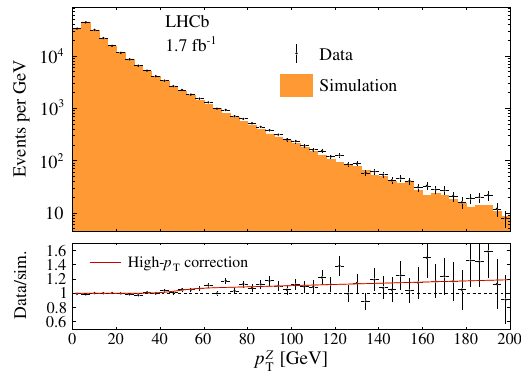
compared to the POWHEGPythia model prior to the parametric Figure 8 . Distribution of p Z T correction, which is delineated by the red line in the lower panel.